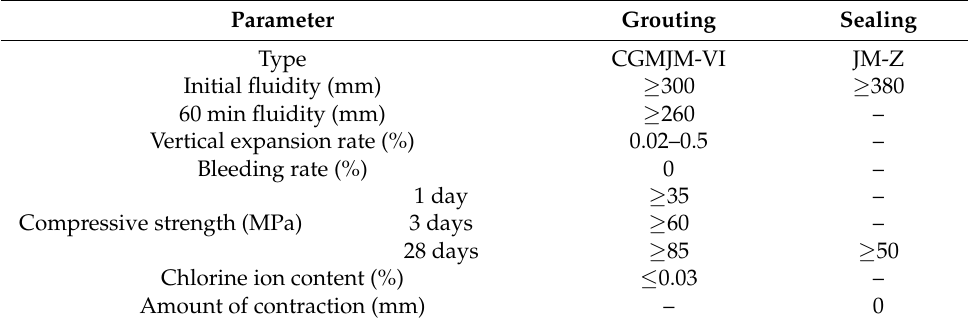
Figure 2. Material for grouting and sealing. ( a ) High strength grouting material. ( b ) Sealing material. Table 2. Properties of assembly materials.